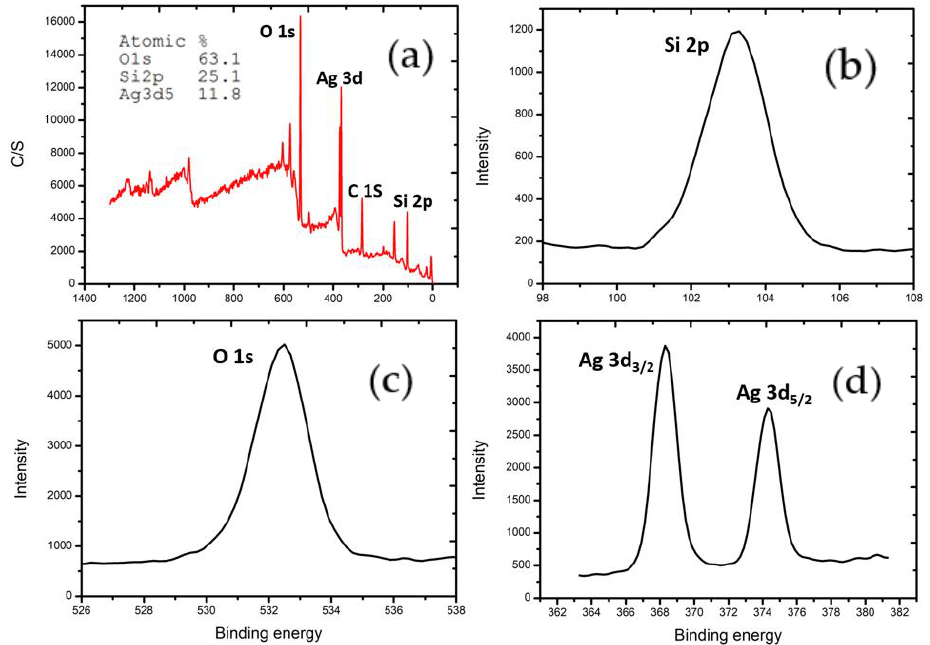
Figure 5. The X-ray photoelectron spectroscopy (XPS) of ( a ) survey scan of AcOHmS ( b ) Si 2p of